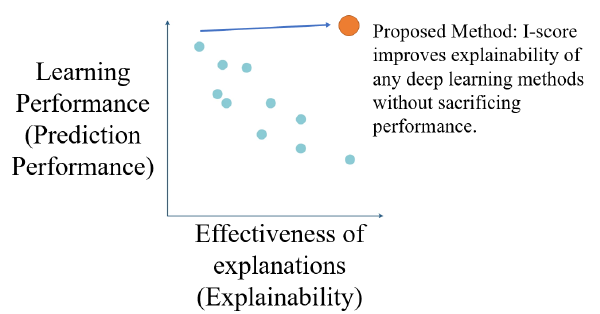
Figure 1. DARPA document (DARPA-BAA-16-53) proposed this figure to illustrate a basic Explain- able AI problem [19,20]. It presents the relationship between learning performance (usually measured by prediction performance) and effectiveness of explanations (also known as explainability). The pro- posed method in our work aims to take any deep learning method and provide explainability without sacrificing prediction performance. In the diagram, the proposed method is the orange dot on the upper right corner of the relationship